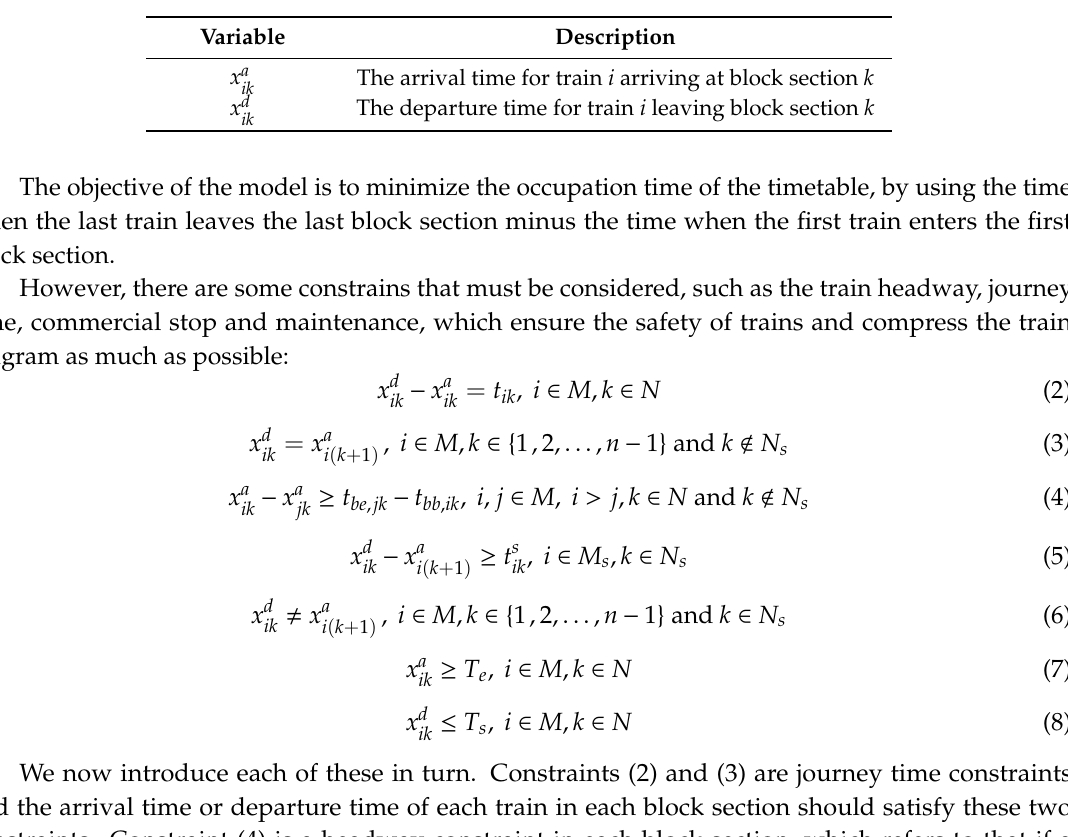
Table 4. List of